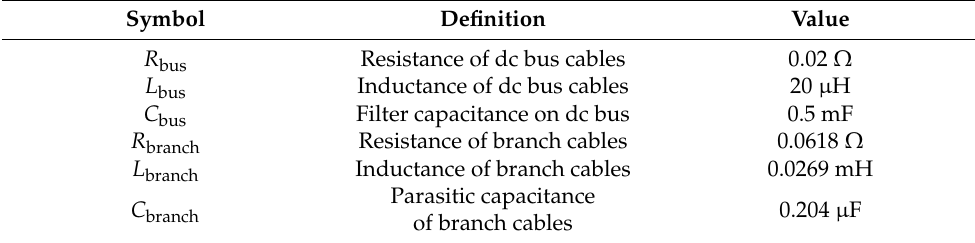
Table 3. Parameters of